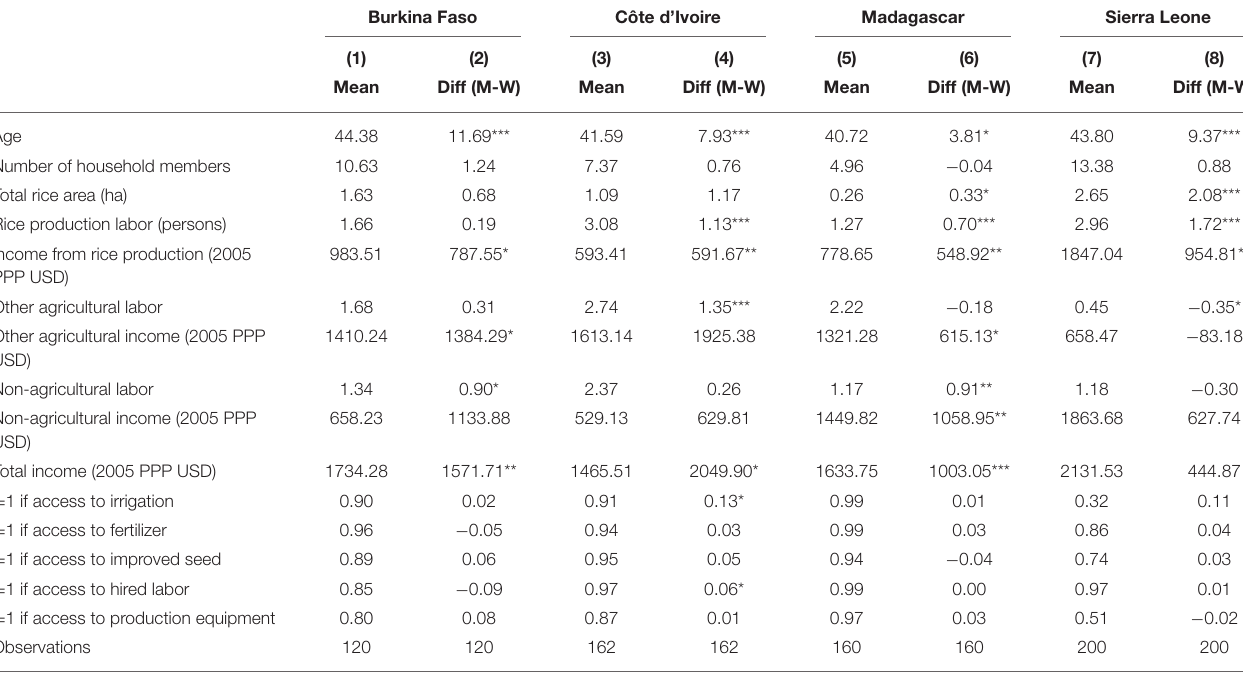
TABLE 2 | Descriptive statistics of factors associated with labor inputs in Burkina Faso, Côte d’Ivoire, Madagascar, and Sierra Leone. Burkina Faso Côte d’Ivoire Madagascar Sierra